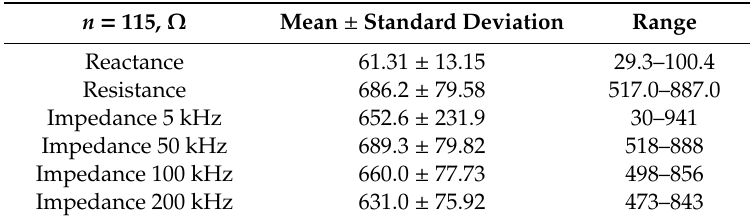
Table 4. Bioelectrical impedance